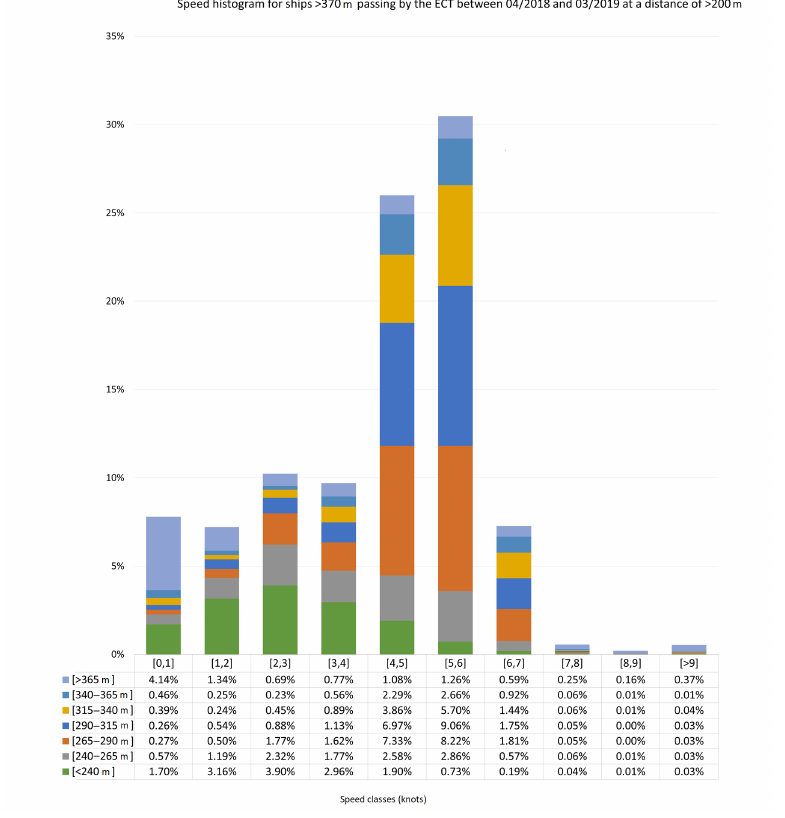
Figure 7. Passing speed histogram in knots for vessels exceeding 370 m between April 2018 and March 2019 at a passing distances greater than 200 m from the terminal